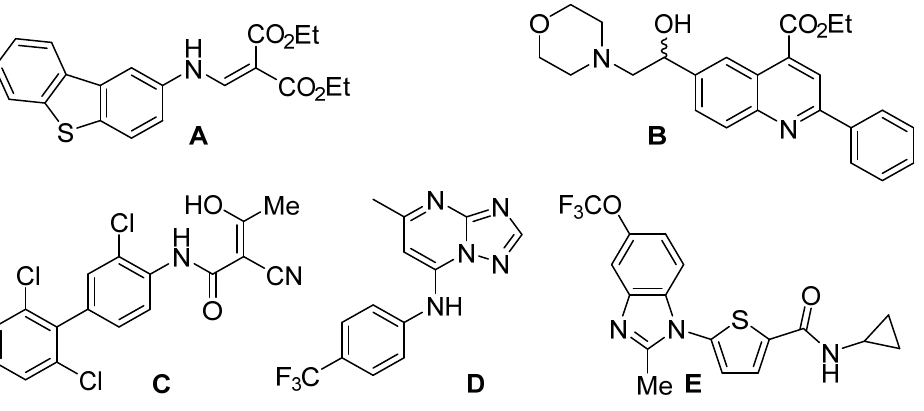
Figure 1. Compounds A – E as examples of known inhibitors of Pf DHODH.